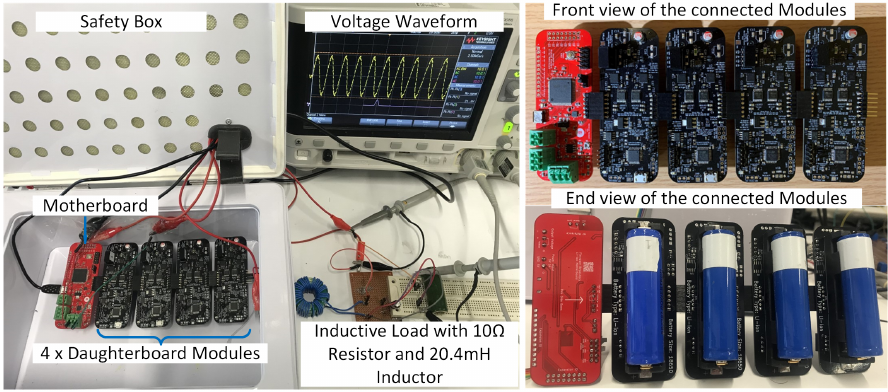
Figure 8. Test setup: battery pack with Li-ion batteries connected to an inductive load. The front and end views of the motherboard and four daughterboards.